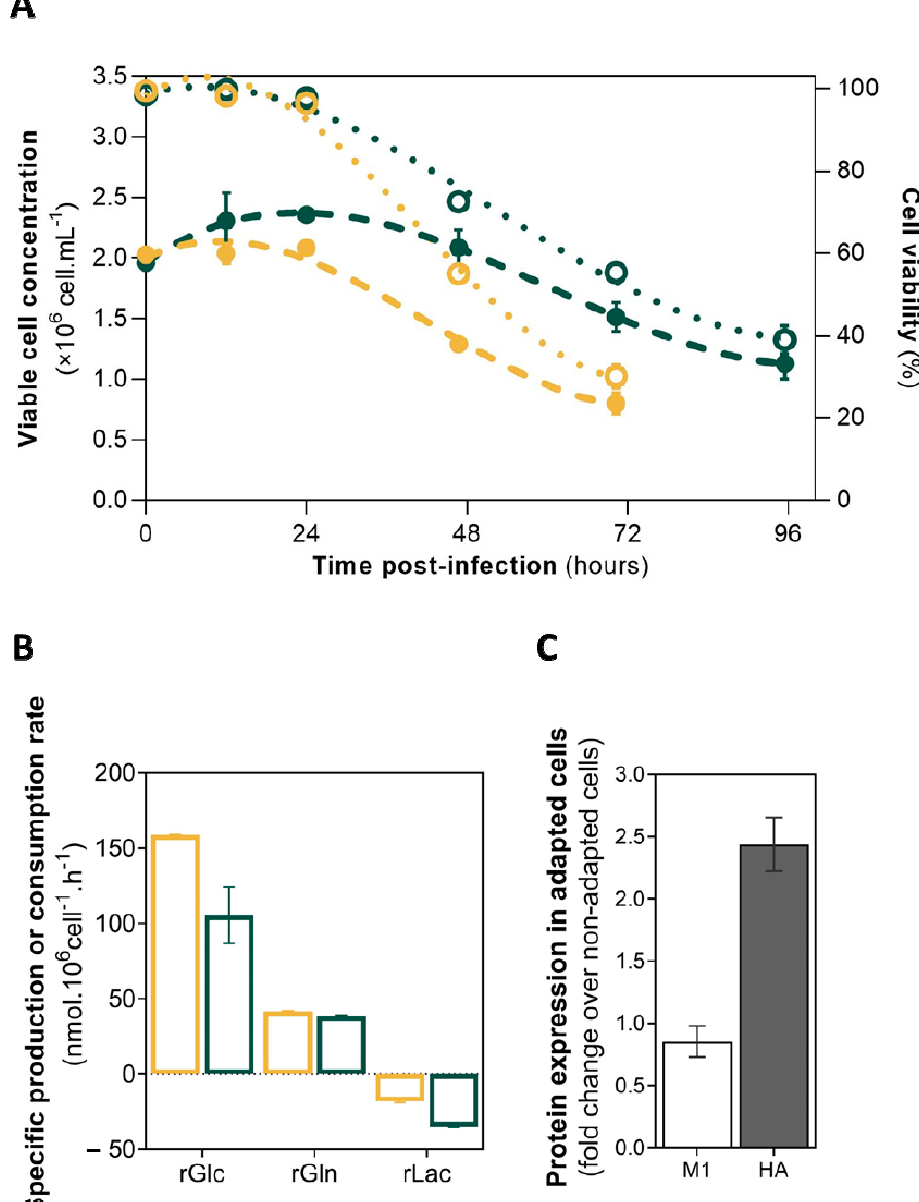
Figure 1. HA-VLP production in non-adapted and adapted High Five insect cells using the baculovirus expression vector system. ( A ) Viable cell concentration (full circles) and cell viability (empty circles) after infection. ( B ) Specific glucose (rGlc) and glutamine (rGln) consumption and lactate (rLac) production (hence shown as negative) rates, estimated by linearization of metabolite concentration and integral of total cells, during infection. ( C ) Fold-change (adapted/non-adapted) in expression of HA and M1 proteins assessed by densitometry analysis of Western blot images (i.e., relative band intensity). Color code: yellow represents non-adapted cells, green represents adapted cells. Data are expressed as mean ± standard deviation of three culture replicates (n = 3).